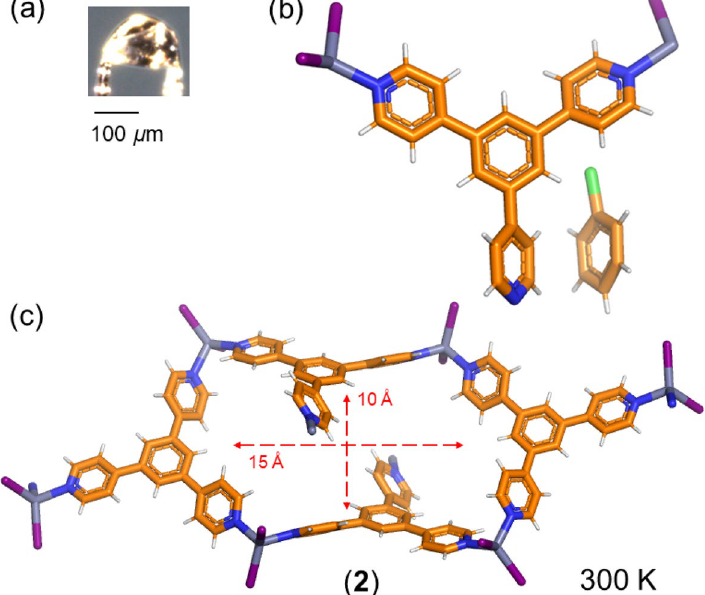
thin plates (Fig. 6a) have lattice parameters and space group symmetry different from those of 1 : a = 24.1055(4) Å, b = 14.4843(2) Å, c = 18.2201(2) Å, β = 100.8630(10), and V = 6247.57(15) Å 3 , crystallizing in the monoclinic system in the C 2/ c space group (Table S2). In the asymmetric unit, there is one TPB ligand and one and a half ZnI 2 , as one of the Zn atoms sits at a special position on a twofold axis. There is also one chlorobenzene guest molecule (Fig. 6b). The chemical for- mula, according to the SC-XRD data, is [( TPB ) 1 (ZnI 2 ) 1.5 ] n ·(C 6 H 5 Cl) ( 2 ). The minimum metal–ligand circuit is formed by four TPB ligands and four Zn(II) metal centers expanding along the c -axis, which leads to infinite 1D channels, including chlorobenzene. The smallest TPB -ZnI 2 circuits form pockets of rectangular shape with windows of ca . 10 Å × 15 Å dimensions (Fig. 6c). The minimum circuits expand through the other two Zn-N coordination bonds to give a tubular structure expanding along the c -axis (Fig. 7a,b). The tubes are large enough to form 1D channels of dimensions ca .